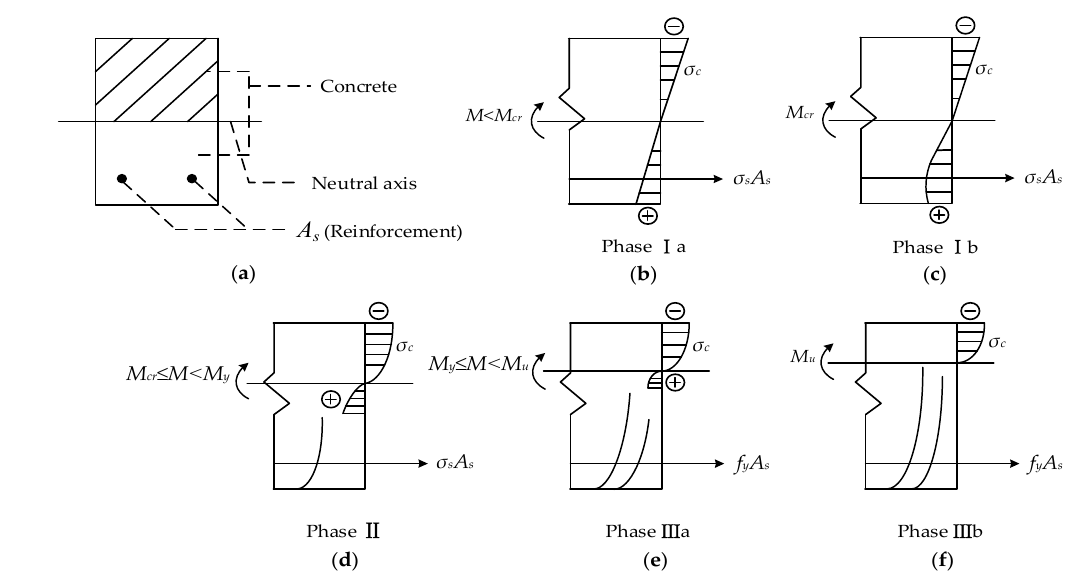
Figure 8. ( a ) A cross-section in the mid-span of a RC beam and its work phases: ( b – f ).